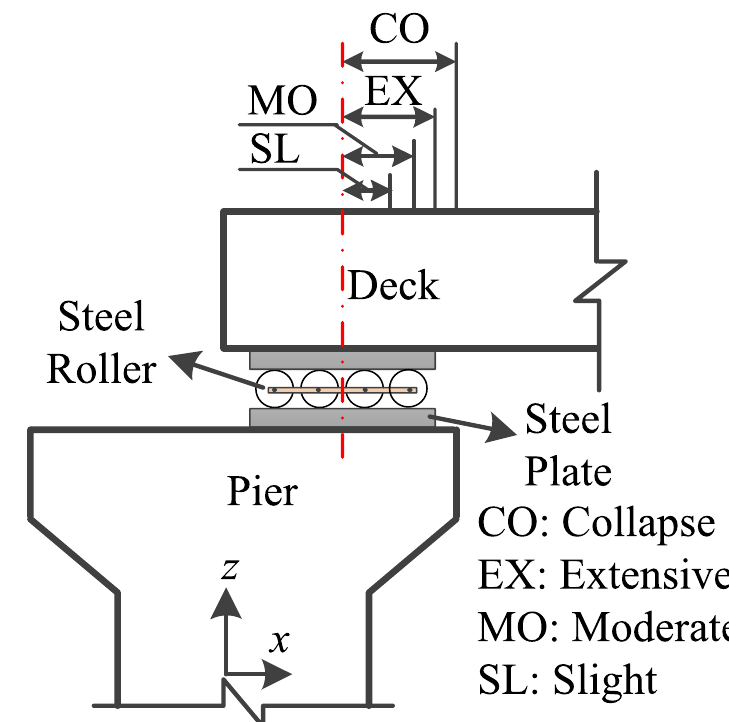
Fig. 7 Damage states of roller